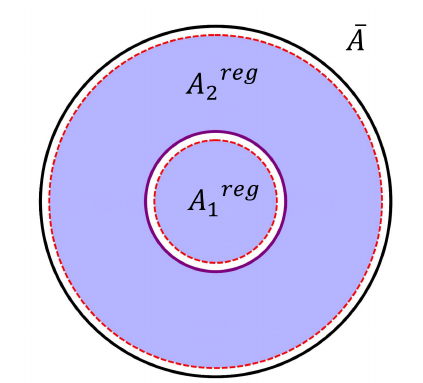
Figure 8: We consider a disk region A which is divided into a concentric smaller disk ∪ A and an annulus A = A . The white region bounded by the solid circle boundaries 1 2 and the red dashed circles are the cutoff regions when we evaluate the entanglement entropies S and S in the ALC proposal . The cutoff region for ¯ A is taken to be A A 1